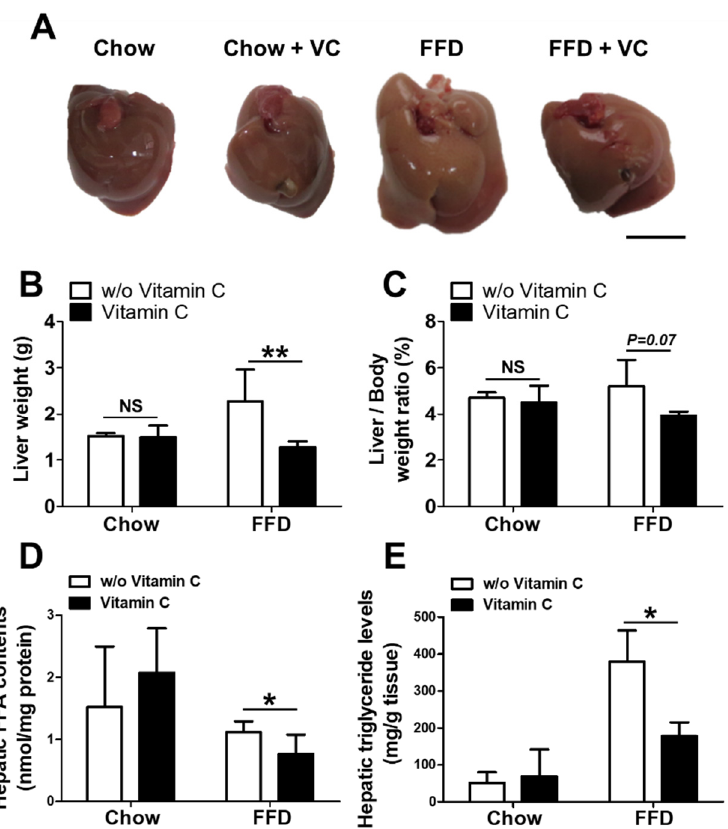
Figure 2. The liver phenotypes and assessment of intrahepatic fat contents. ( A ) Representative liver images of chow-diet fed and FFD-fed mice groups; ( B ) The average liver weight; and ( C ) liver/body weight ratio (%); ( D ) Hepatic free fatty acid (FFA) contents; ( E ) Hepatic triglyceride levels. Data are expressed as means ± SD per group ( B – E ). n = 5 mice in each group ( B – E ). ns = not significant ( p >0.05), * p < 0.05, ** p < 0.01. Scale bars = 1 cm ( A ).